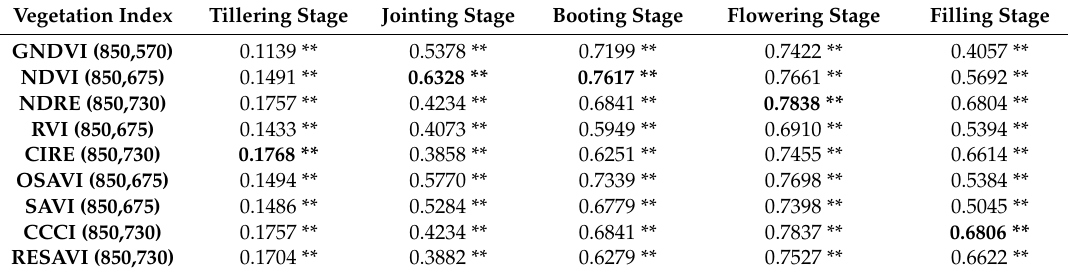
Table 4. Determination coe ffi cients between grain yield and di ff erent vegetation